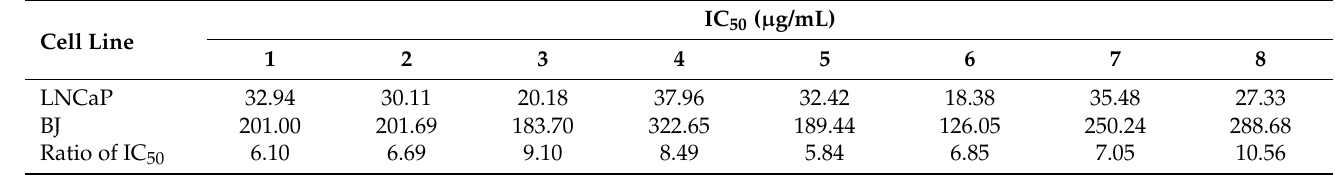
Table 9. IC 50 values ( µ g/mL) after exposure of human prostate cancer cells (LNCaP) and human normal foreskin fibroblasts (BJ) to the Epilobium sp. extracts for 24 h. The ratio between the IC 50 s for the cancerous and normal cells obtained was also calculated for selectivity